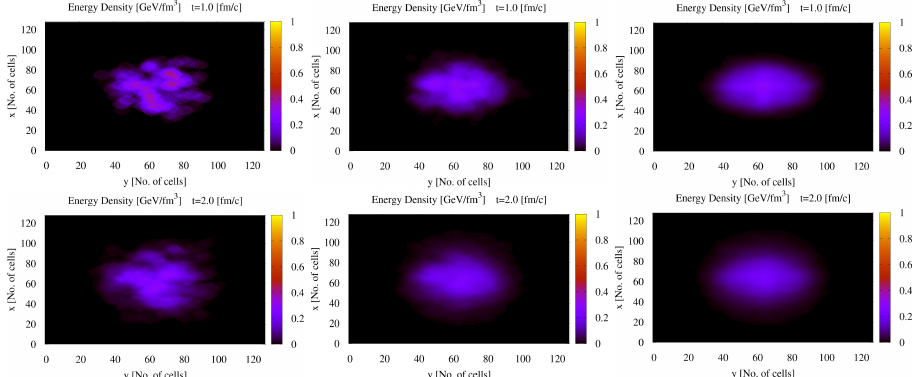
Figure 2. Energy density cross-section in 2D (xy plane with z = 12.8 fm)